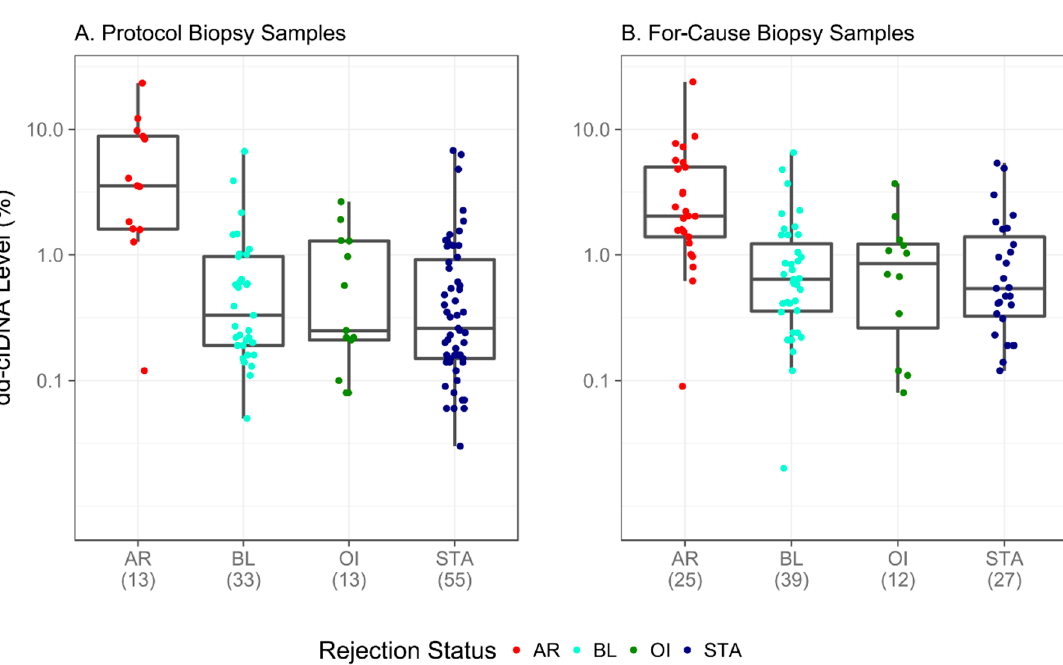
Figure 4. Discrimination of active rejection by dd-cfDNA in biopsy-matched samples stratified by biopsy type. The number of samples per group and the distribution of their dd-cfDNA levels are depicted for protocol biopsy ( A ) and for-cause biopsy ( B ) samples. Boxes indicate inter-quartile range, horizontal lines represent medians. AR, active rejection; BL, borderline; OI, other injury; STA, stable.